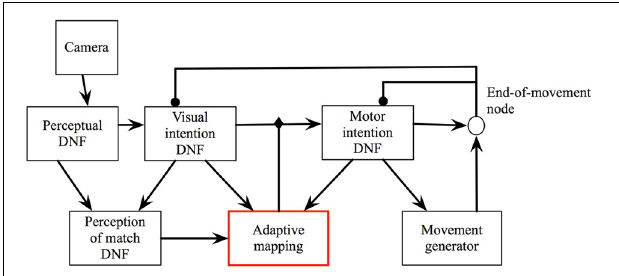
FIGURE 4 | The DFT architecture for looking. See main text for